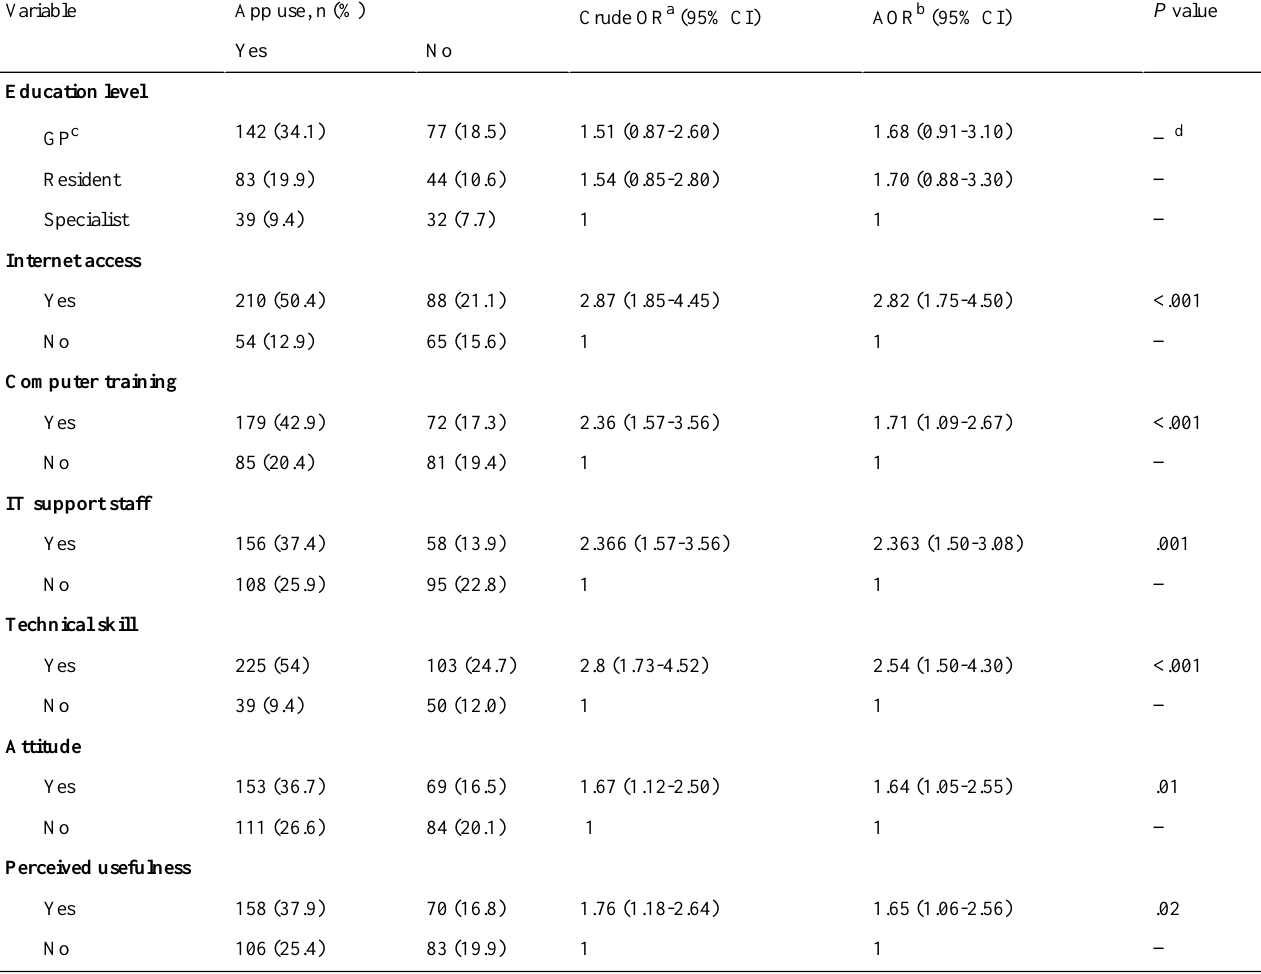
Table 6. Bivariable and multivariable regression analysis of factors with smartphone medical app use among physicians in referral hospitals of Amhara regional state, North Ethiopia, 2019